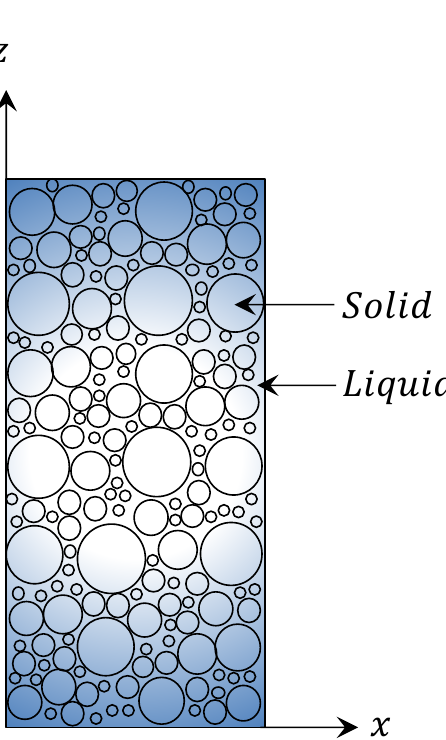
Figure 1. Two phases of representative elementary volume.